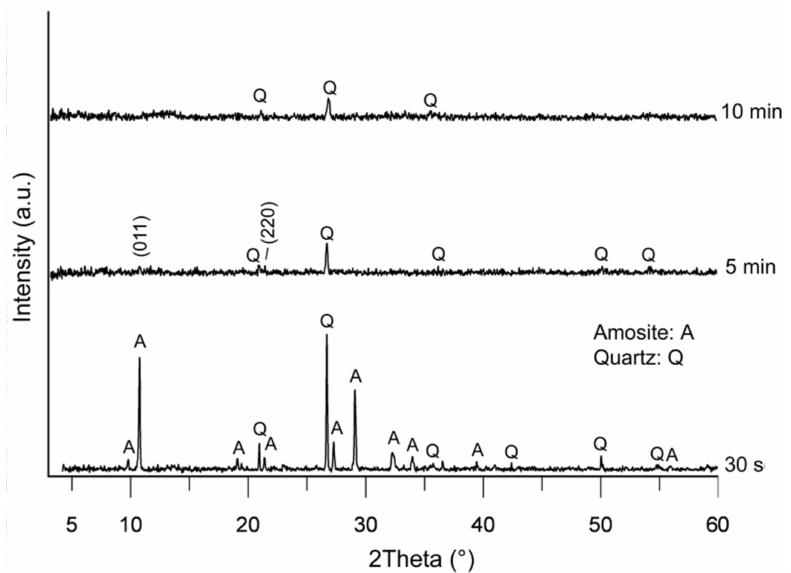
Figure 2. XRPD patterns of amosite recorded after 30 s, 5 min and 10 min of grinding